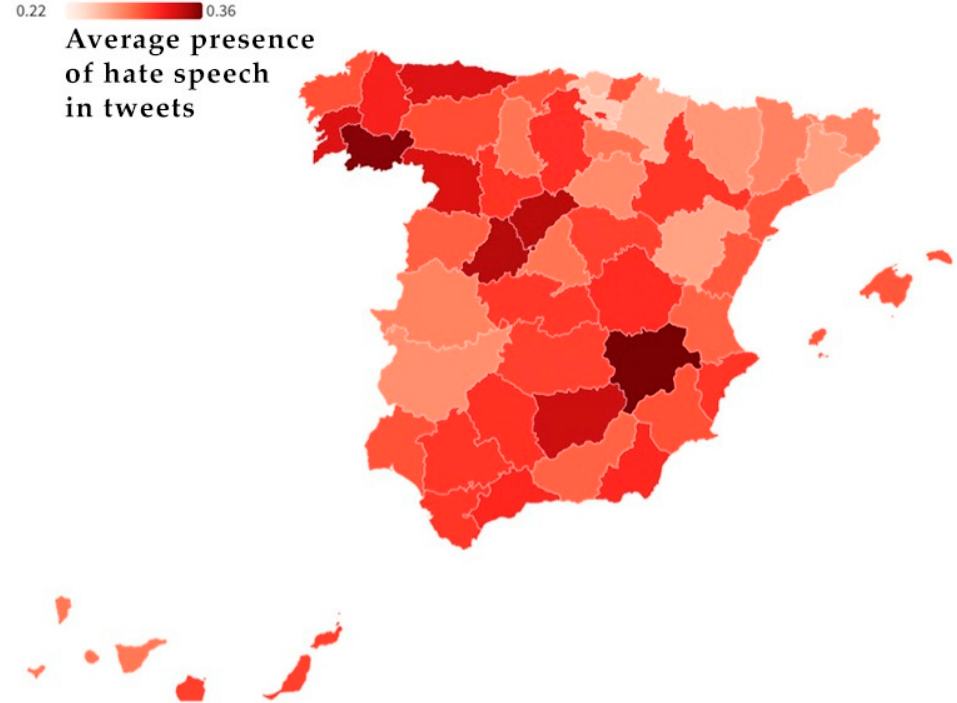
Figure 4. Hate speech total average present on Twitter in Spain. Own elaboration.